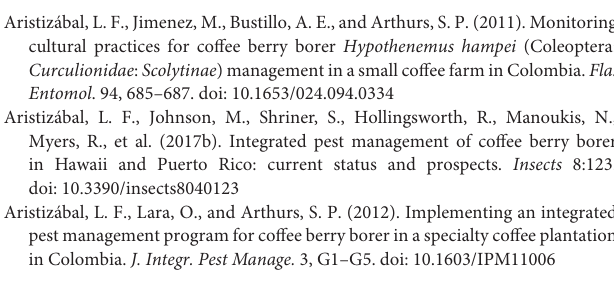
Table S1 | CBB field infestations and control costs for individual